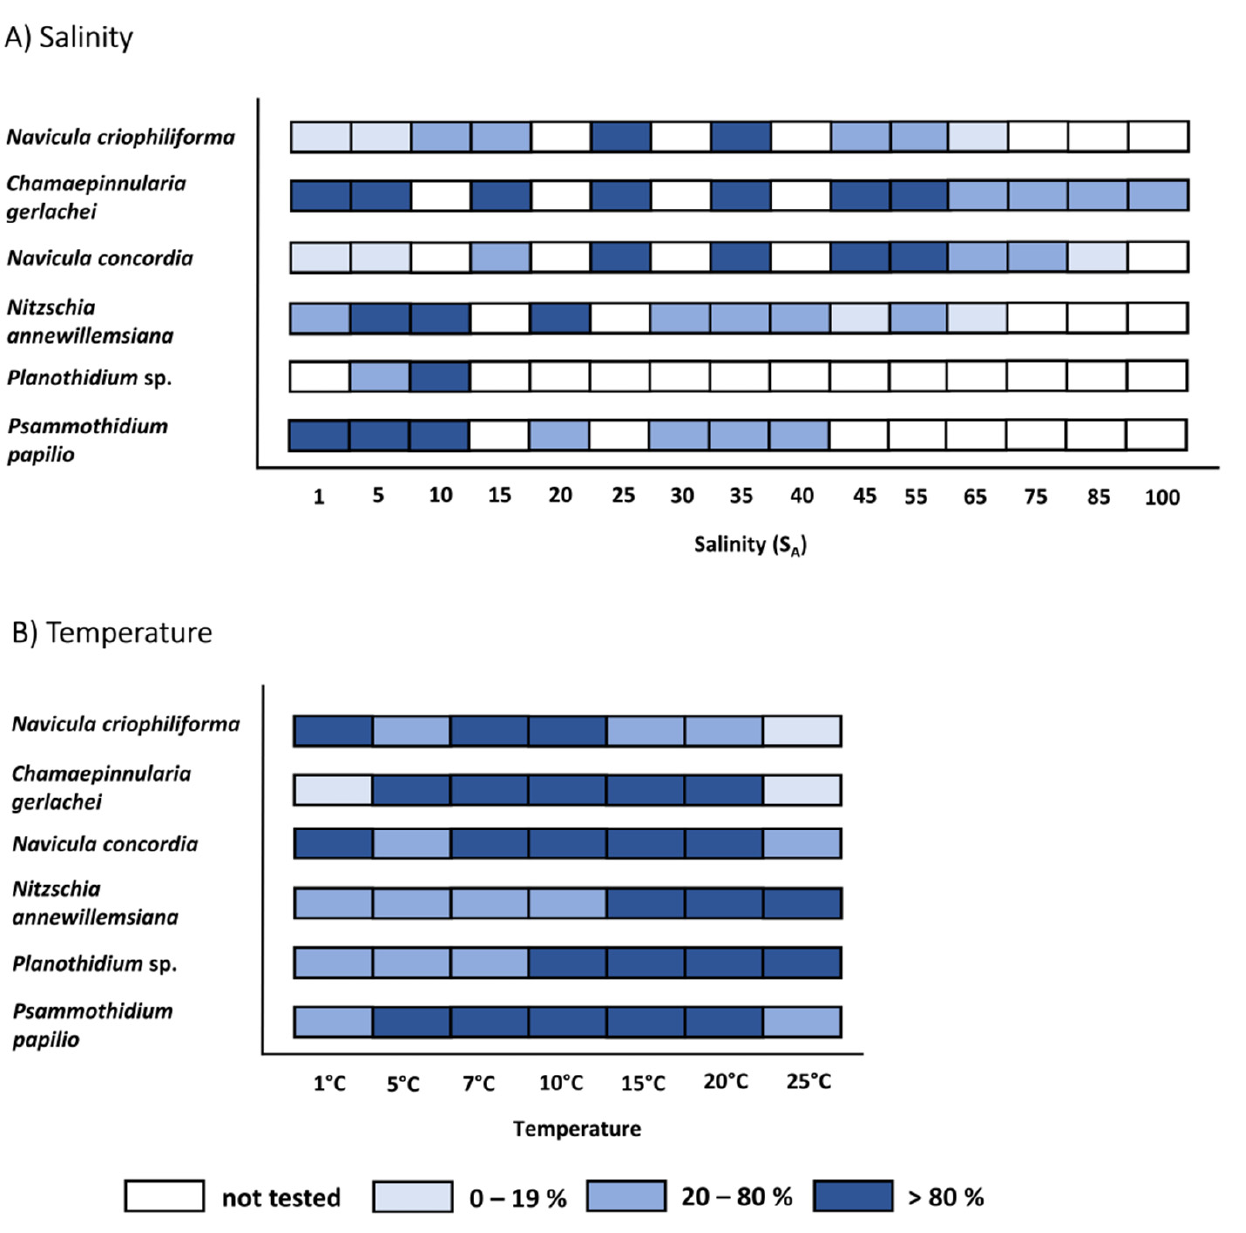
Figure 6. Effects of ( A ) salinity and ( B ) temperature on the effective quantum yield of photosystem II (Fv/Fm) of six benthic diatom strains from Antarctica. Dark blue symbols represent the range of the highest effective quantum yield at the 80th percentile and above, medium blue symbols are between the 20th and 80th percentiles, light blue symbols represent the 20th percentile and below, and white symbols were not tested. Data represent mean values ( n = 6).